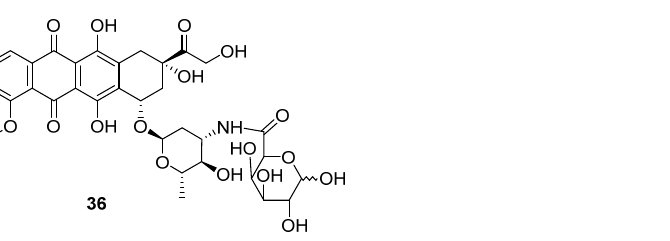
Figure 5. Galacturonamide of doxorubicin ( 36 ) for lectin-directed enzyme-activated prodrug therapy (LEAPT) [76].